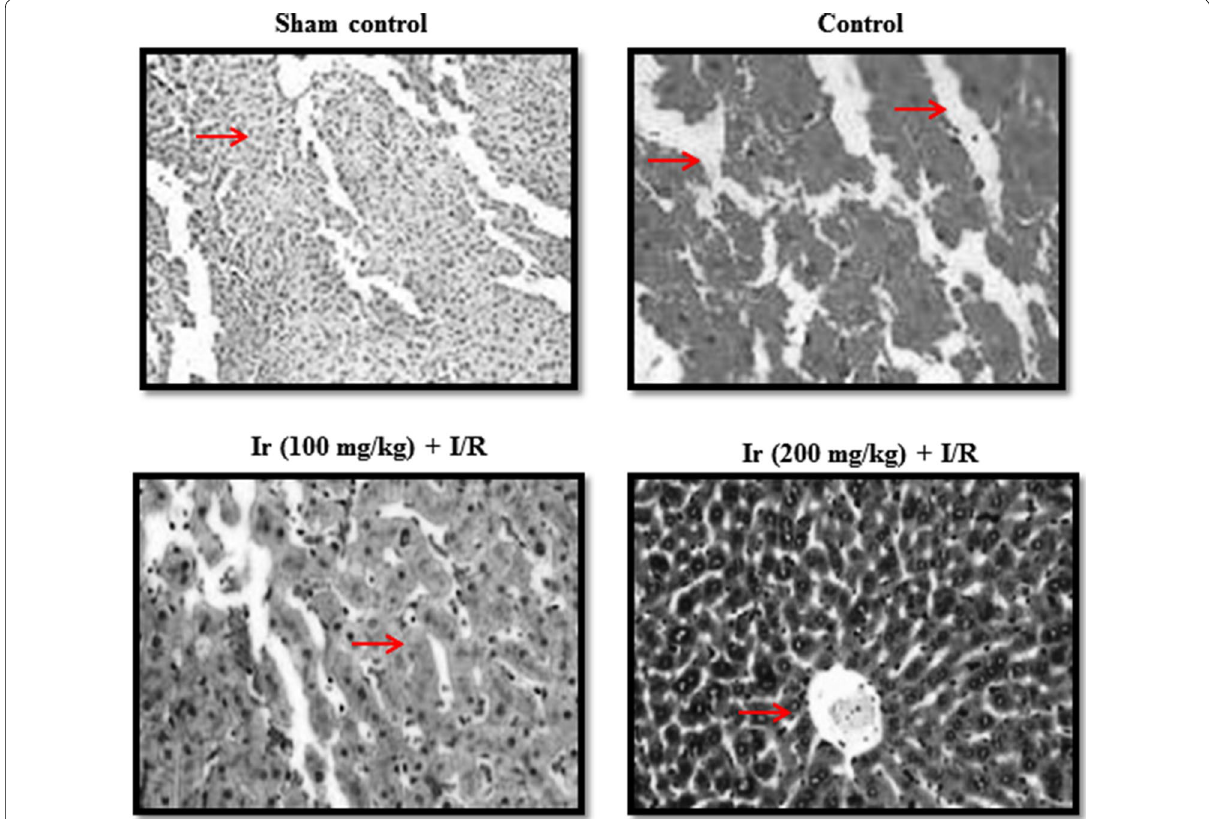
Fig. 6 Ir attenuated altered cell morphology. Normal cellular architecture, and no congestion and necrosis (group I). Inflammation, congestion, and necrosis (group II). Attenuated inflammation, congestion, and necrosis (group III and IV). The representative images were obtained from six independent experiments